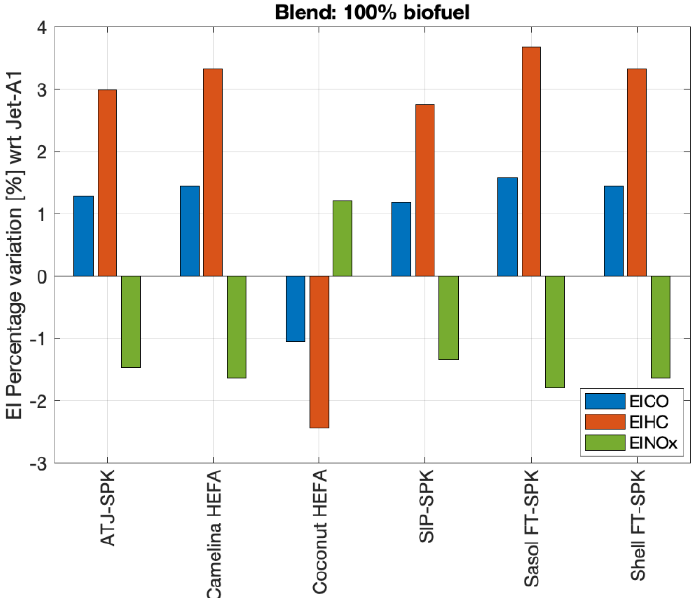
Figure 11. Theoretical maximum EI percentage variation due to the substitution of traditional fuel